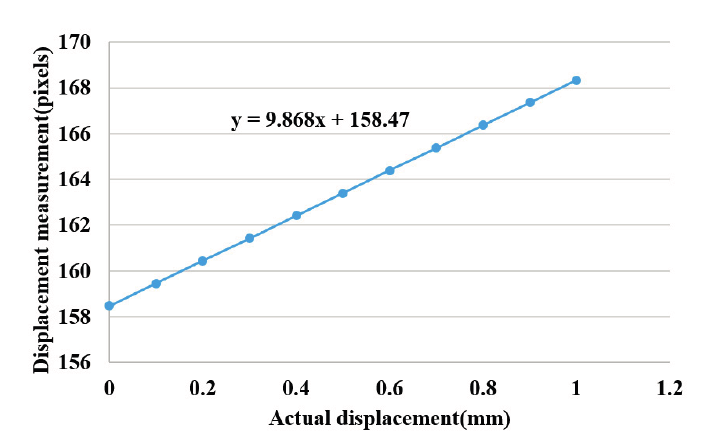
Figure 13. Height displacement calibration.